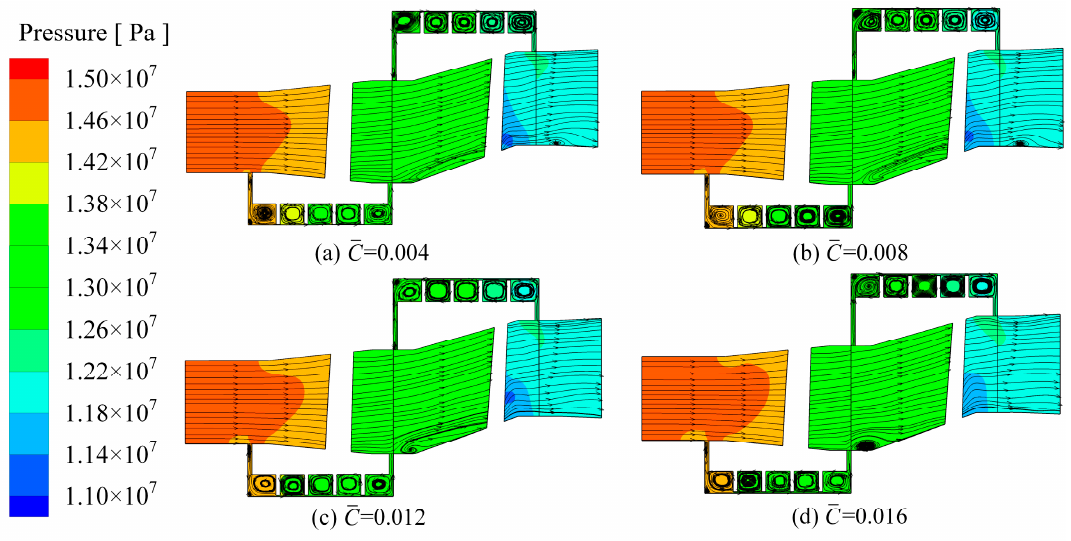
Figure 5. The static pressure contours of the meridional planes.